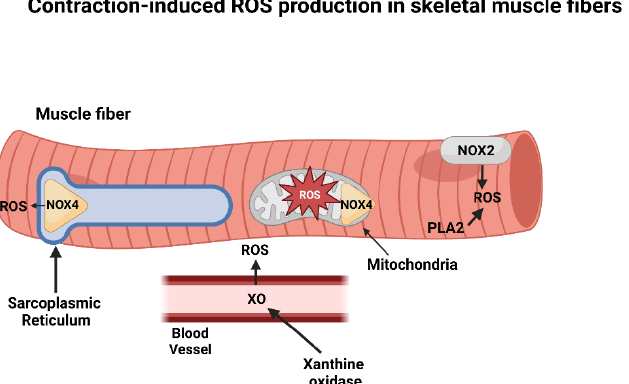
Figure 1. Potential sites of ROS production in skeletal muscle fibers during contractile activity. See text for details. Key: NOX2 = NAD(P)H oxidase 2; NOX4 = NAD(P)H oxidase 4; PLA2 = phospho- lipase A2; ROS = reactive oxygen species. Figure created by